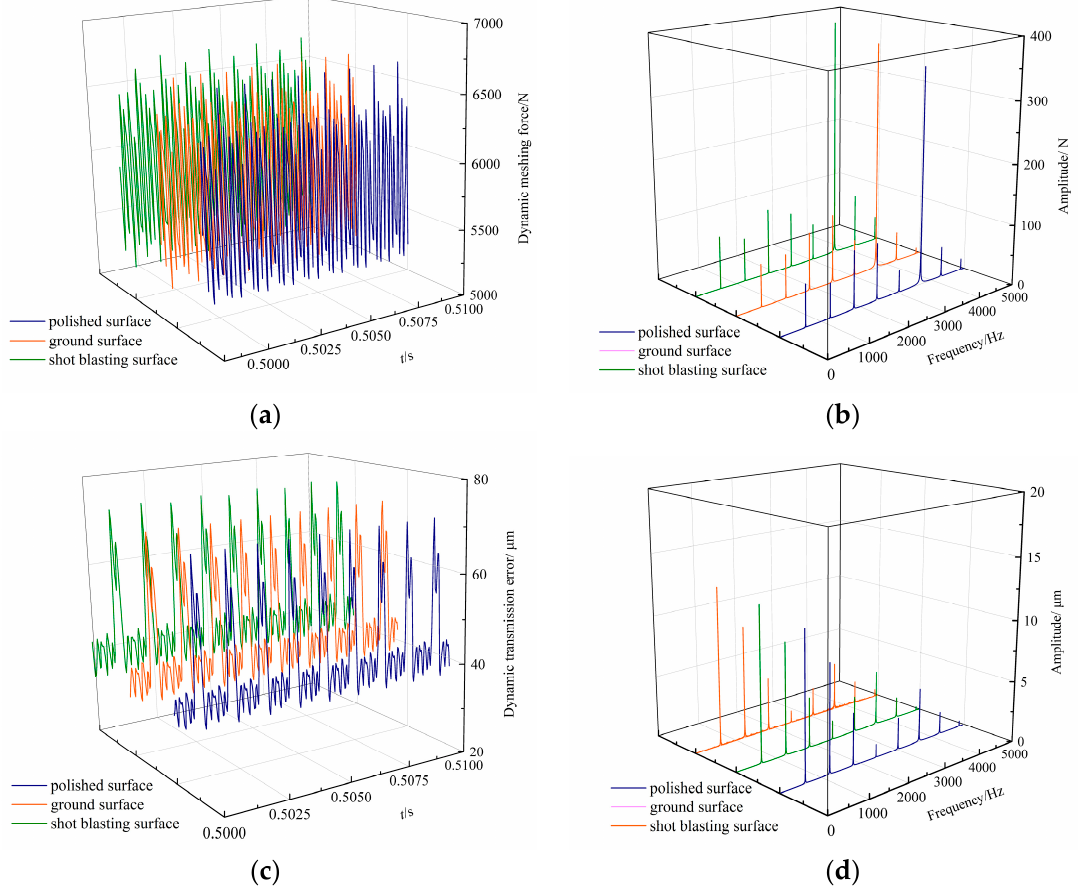
Figure 14. DMF and DTE of different surfaces. ( a ) DMF. ( b ) Frequency domain spectrum. ( c ) DTE. ( d ) Frequency domain spectrum.